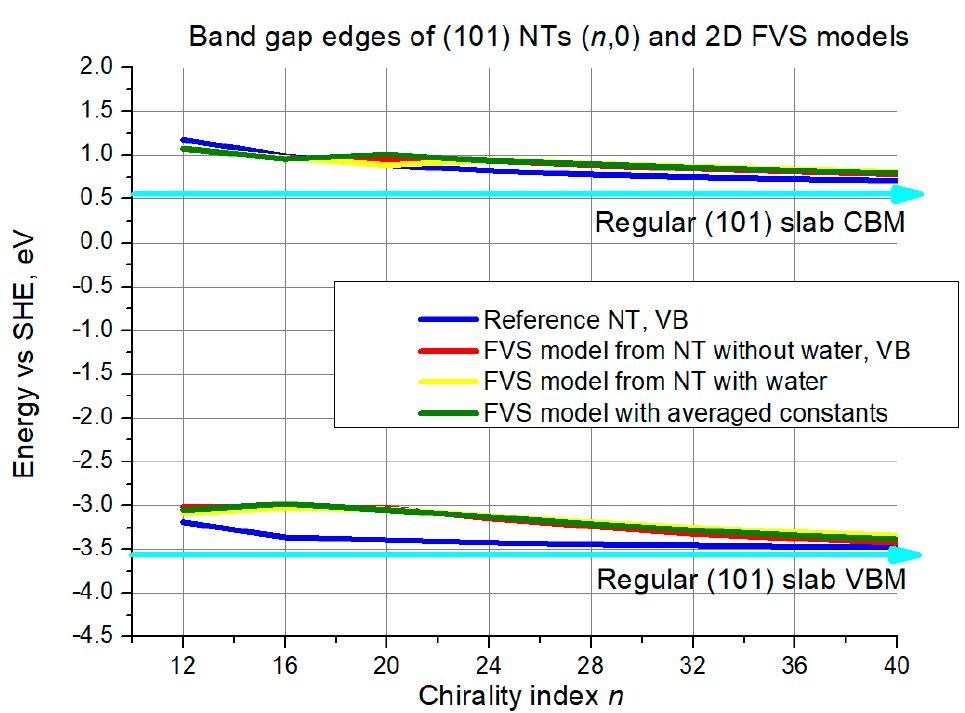
Figure 8. VB top and CB bottom edge positions for (101) NTs ( n, 0) and their 2D FVS models. The cyan lines with arrows denote slab limit for VB maximum and CB minimum.